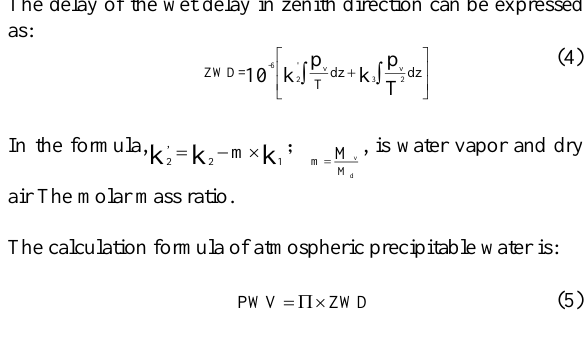
Figure 1. Comparison of different methods of obtaining coordinates （ WHUN